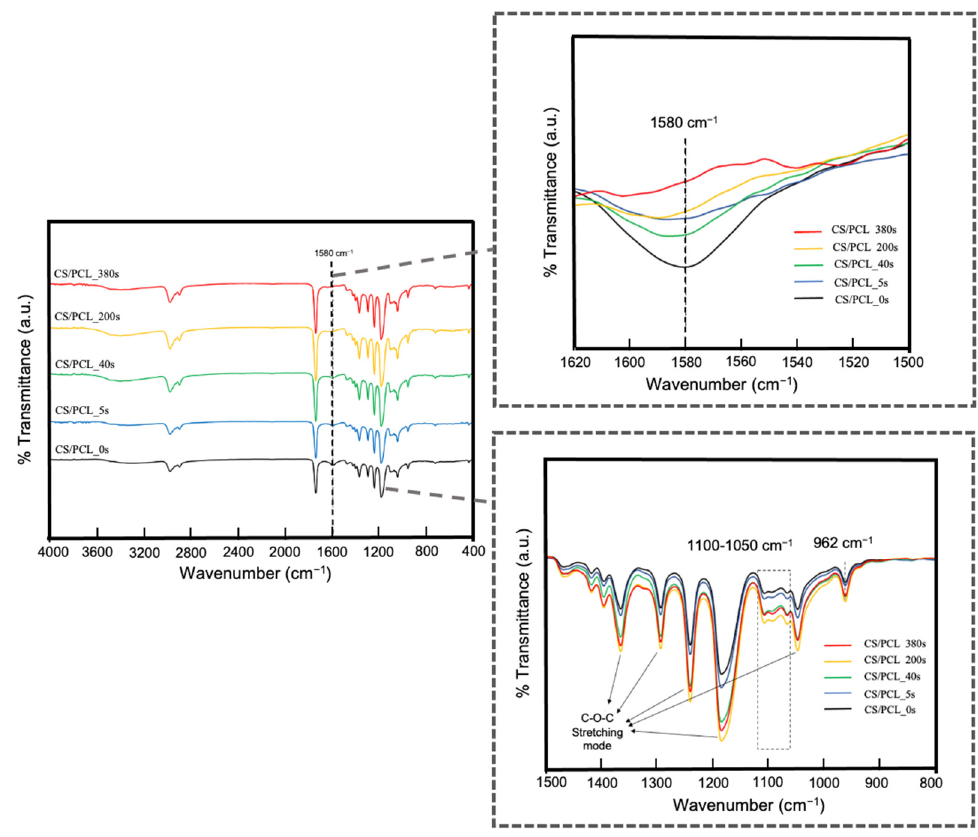
Figure 3. FT-IR spectra of CS/PCL with various APNP exposure time.